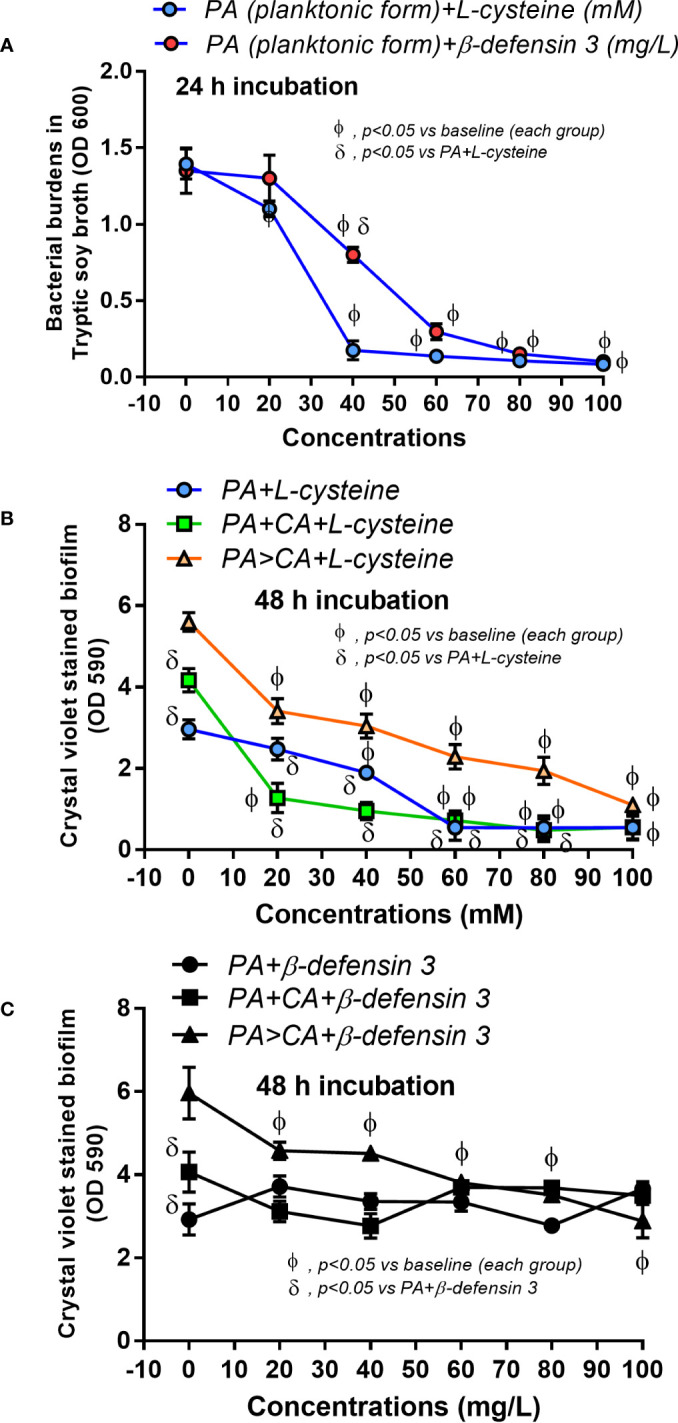
Effect of the different concentrations of l-cysteine and β-defensin 3 on bacterial burdens in TSB culture of planktonic P. aeruginosa after 24 h incubation (A) and crystal violet–stained biofilms on 96-well plates after 48 h incubation (B, C) are demonstrated. Mean ± SE was used for data presentation. The differences between groups were examined by Student’s t-test (A) and by one-way ANOVA followed by Tukey’s analysis (B, C). The differences between the individual time points versus the baselines were examined by repeated-measures ANOVA analysis (A–C). A p-value of < 0.05 was considered statistically significant. (Independent triplicate experiments were performed.)